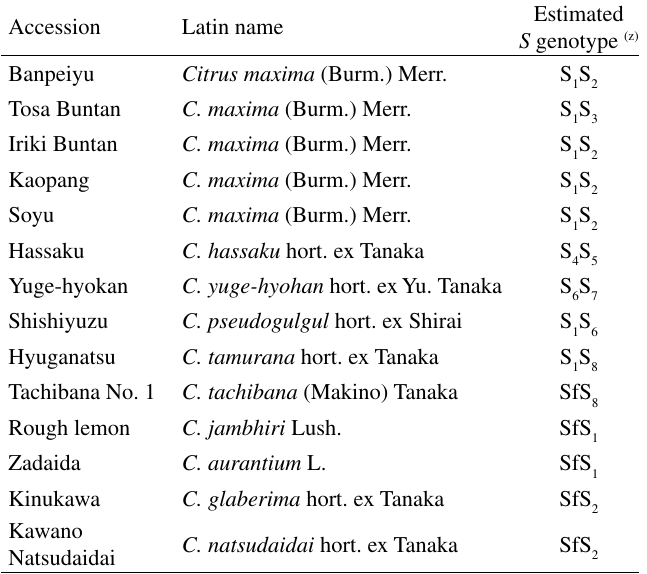
Table 3 - Estimated S genotype of citrus accessions (Kim et al ., 2011; Ngo et al ., 2010,